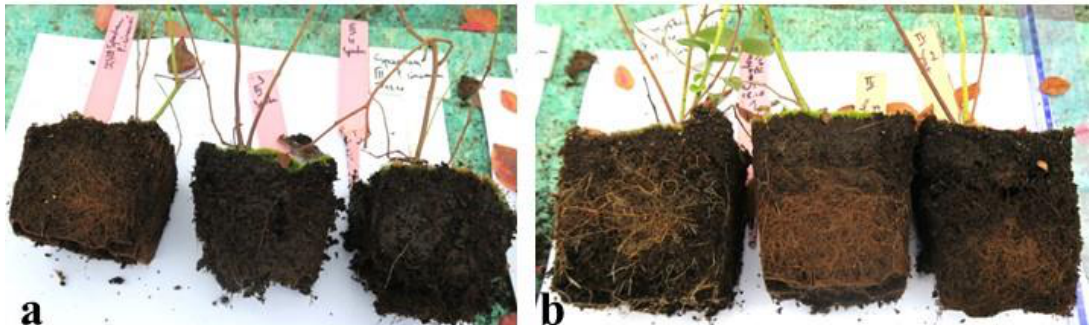
Figure 4. Root balls of highbush blueberry ‘Spartan’. ( a ) Inoculated with P. cinnamomi. ( b ) Inoculated with Serendipita. indica + P. cinnamomi (after 21 days), after 24 months of the experiment.